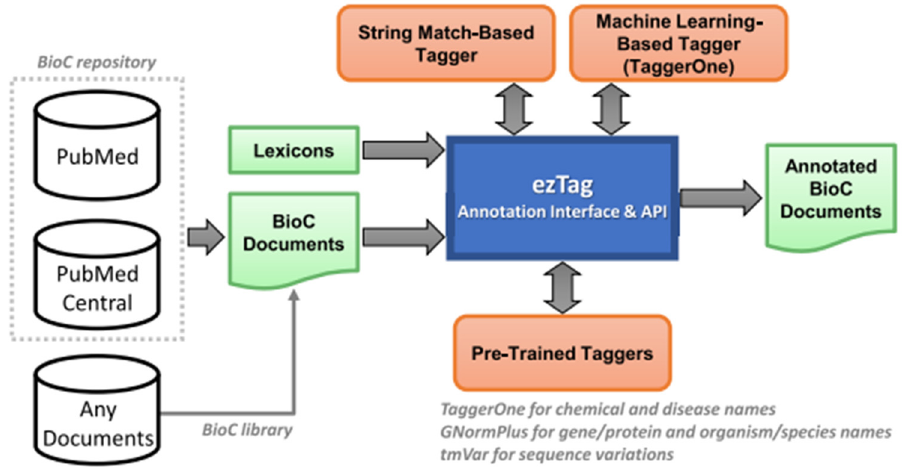
Figure 3. Overview of the ezTag system (cited from [23]).